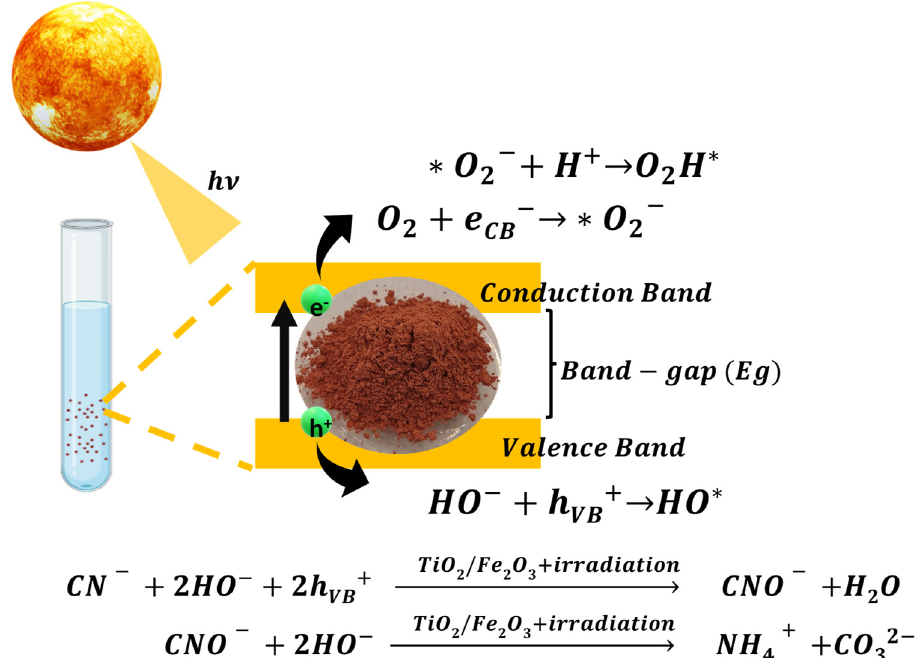
Figure 10. Scheme of cyanide photodegradation using natural sunlight. On the other hand, the TiO 2 /Fe 2 O 3 catalyst photodegrades cyanide by 61.94%, which may be because it absorbs photons in a smaller proportion than the other two materials in this region (see Figure 5) or that there is electron-hole recombination. Figure 11